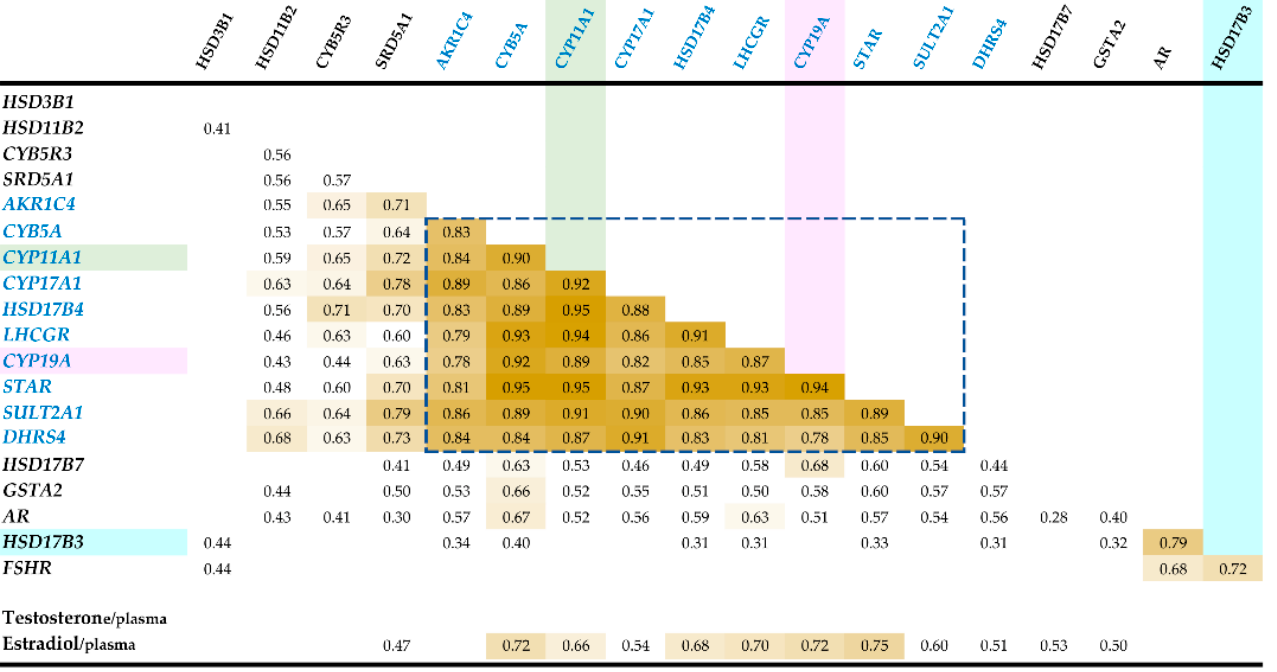
Figure 1. Correlations detected by the analysis of RT-qPCR results. These RT-qPCRs were performed on 33 genes, but only correlations concerning 18 genes and with p < 0.01 are reported. The correlations between the testicular expression of genes and plasma concentrations of testosterone and 17 β -estradiol are presented at the bottom of this diagram.